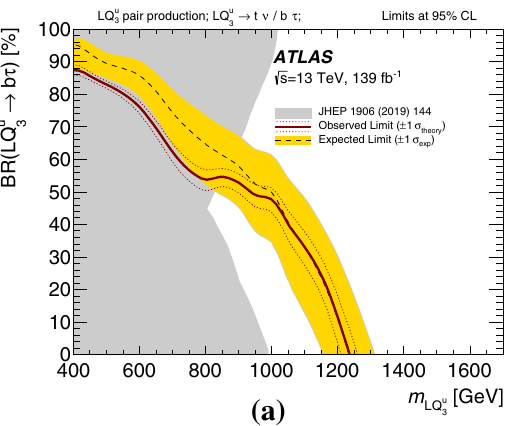
Fig. 14 Observed (red solid line) and expected (black dashed line) limits on up-type, third-generation leptoquarks. a Limits as a function of the branching ratio of leptoquarks decaying into b τ (with the only other decay allowed being into t ν ) vs leptoquark mass. b Limits on the production cross section at 95% CL as a function of leptoquark mass